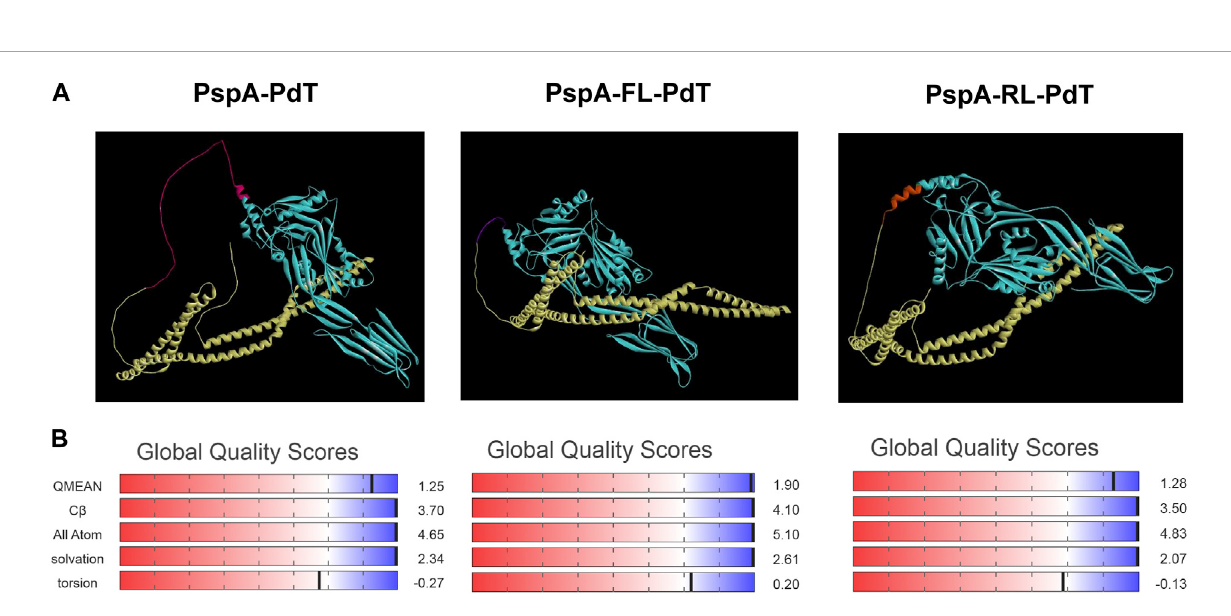
Predicted three-dimentional models of the hybrid proteins predicted by AlphaFold2 and visualized in Discovery Studio Visualizer (A) , and model quality estimation by QMEAN scores (B) . PspA is shown in yellow and PdT, in cyan (A) . Other colors in the models correspond to the following: for PspA-PdT, the indicated area in pink presented instability in previous works and was removed for the new constructions; for PspA-FL-PdT, fl exible linker between the proteins is shown in purple; for PspA-RL-PdT, rigid linker (alpha-helix forming) between the proteins is shown in